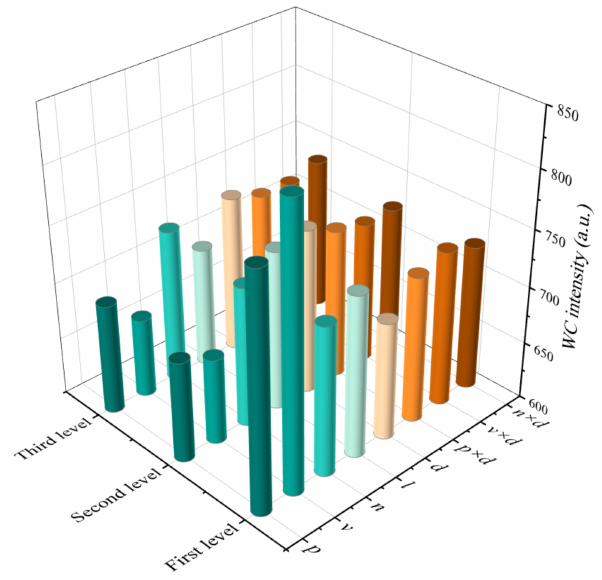
Figure 4. WC phase range analysis